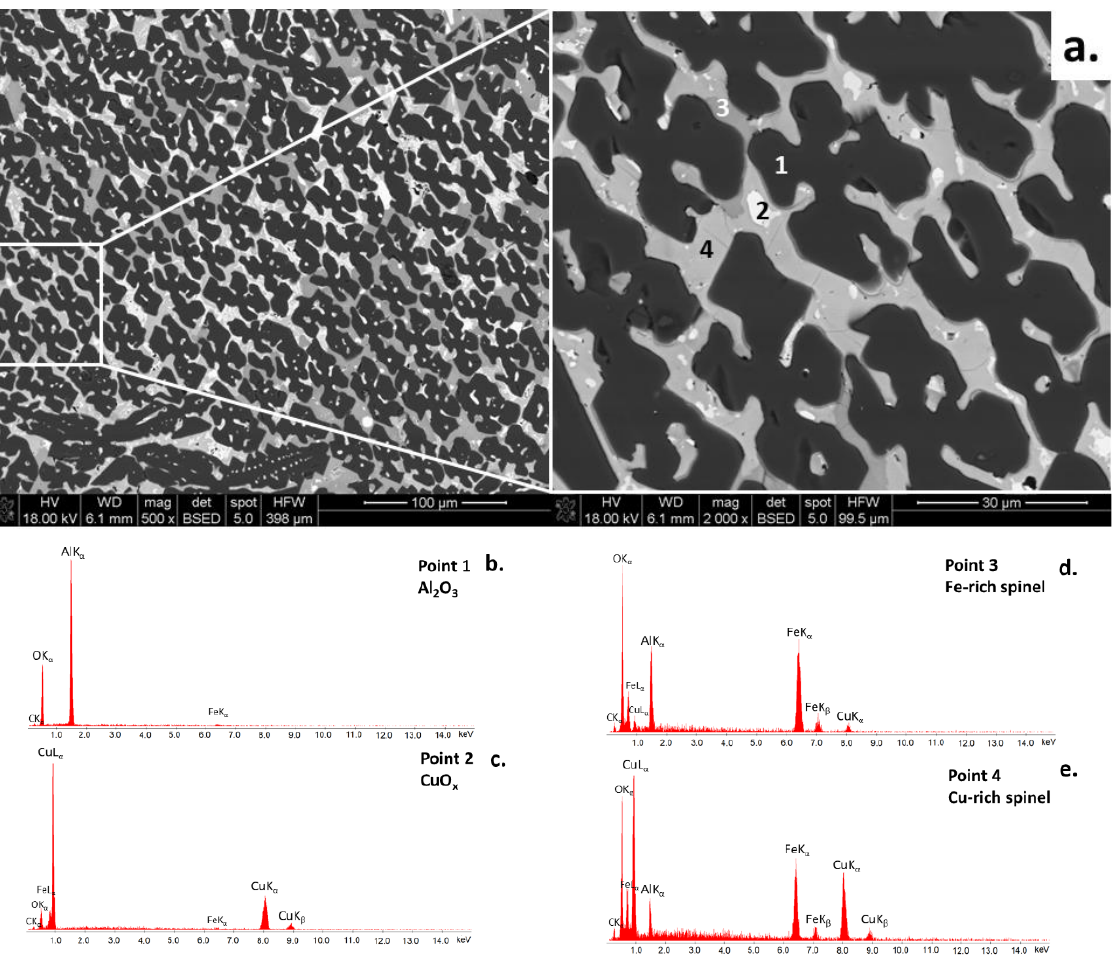
Figure 2. (a). SEM microstructure image of ceramic high-temperature material together with EDS spectra in points 1 – 4 ( b – e ). Table 1. EDS analysis of microareas of high-temperature ceramic material corresponding to Figure